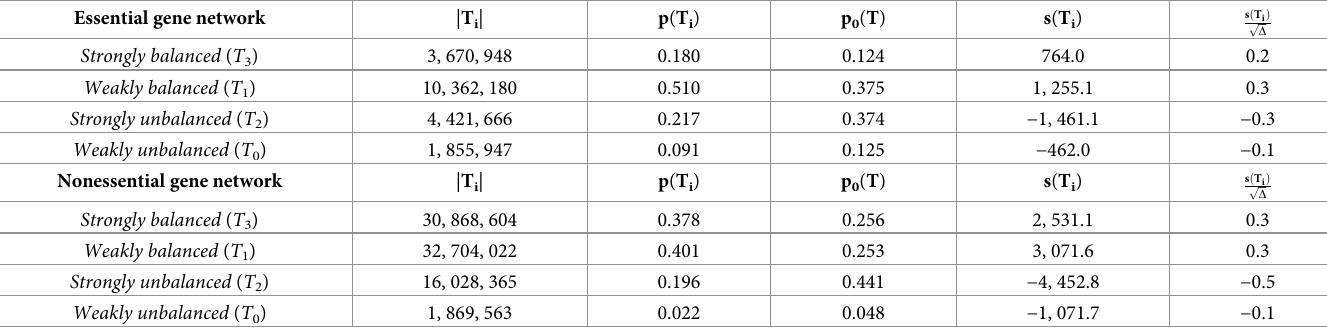
Table 3. Number and probability of balanced and unbalanced triads in the original networks compared to the null model. Essential gene